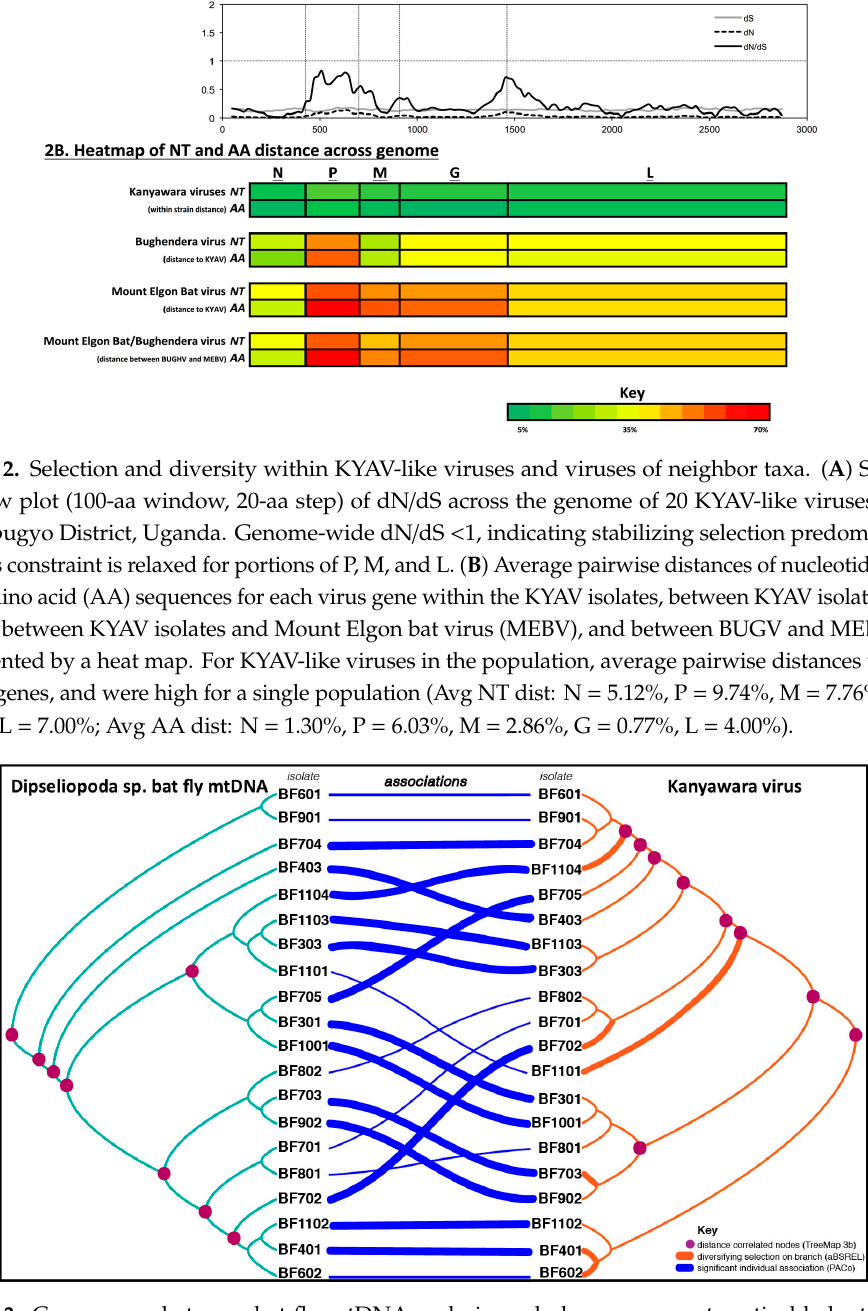
Figure 3. Congruence between bat fly mtDNA and virus phylogeny suggest vertical ledantevirus transmission. Tanglegram generated by TreeMap 3.0b for 7 concatenated bat fly mtDNA genes (NAD1–3, COX1–3, CYTB) (left) and concatenated KYAV-like virus coding sequence (right). Host-virus associations are indicated by crossing blue lines. Individual host-virus links with Procrustes application to cophylogenetic analysis (PACo) procrustean squared residuals below the mean value for all links are believed to contribute significantly to the overall cophylogenetic structure, and are indicated by weighted blue associations lines. TreeMap 3.0b Distance Correlation was performed, and host and virus tree node pairs leading to significantly correlated subtrees ( p < 0.05) are marked with purple dots. Adaptive branch-site random effects likelihood (aBSREL) detected significant ( p < 0.05) evidence of episodic diversifying selection on 6 of 37 virus tree branches (indicated by weighted orange lines).